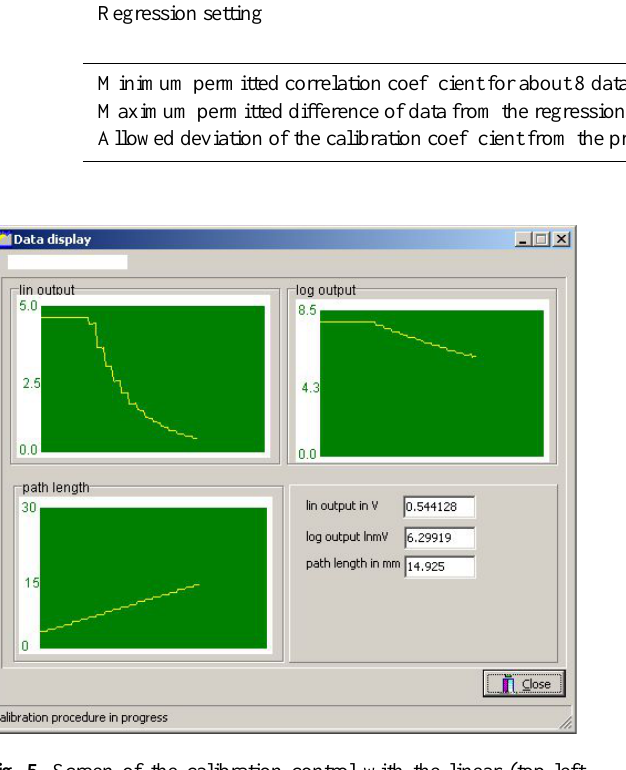
Fig. 5. Screen of the calibration control with the linear (top left panel) and logarithmic (top right panel, comparable with Fig. 6) output signals and the steps of the changing path length (bottom left panel).